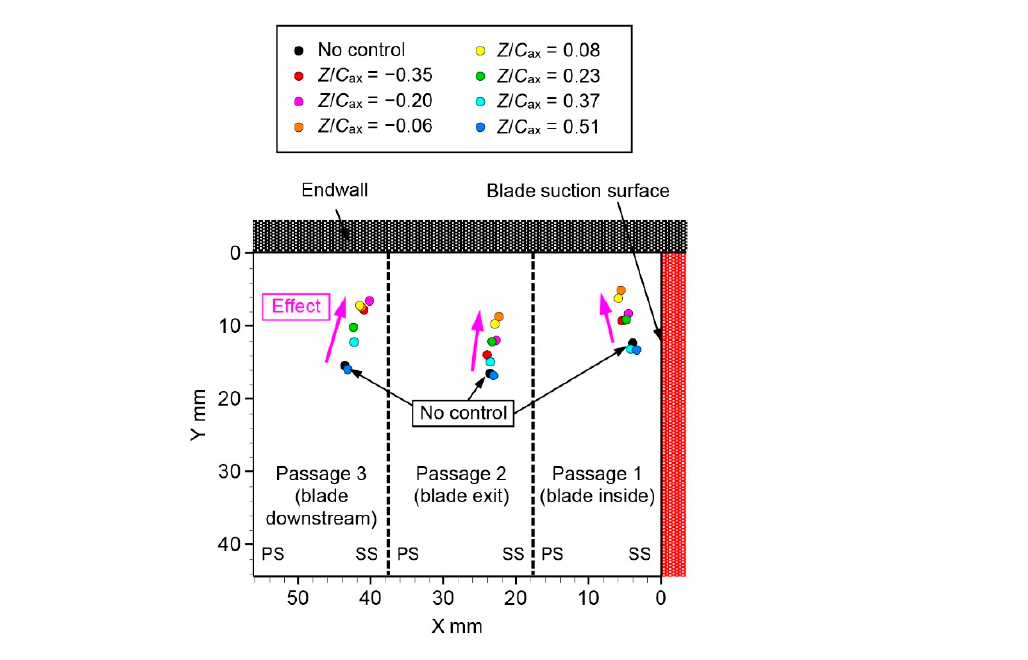
decreases, and the position of the passage vortex becomes the same as that for no control. Figure 21. Effect of the plasma actuator location on the center position of the passage vortex (Re out = 3.7 × 10 4 ).